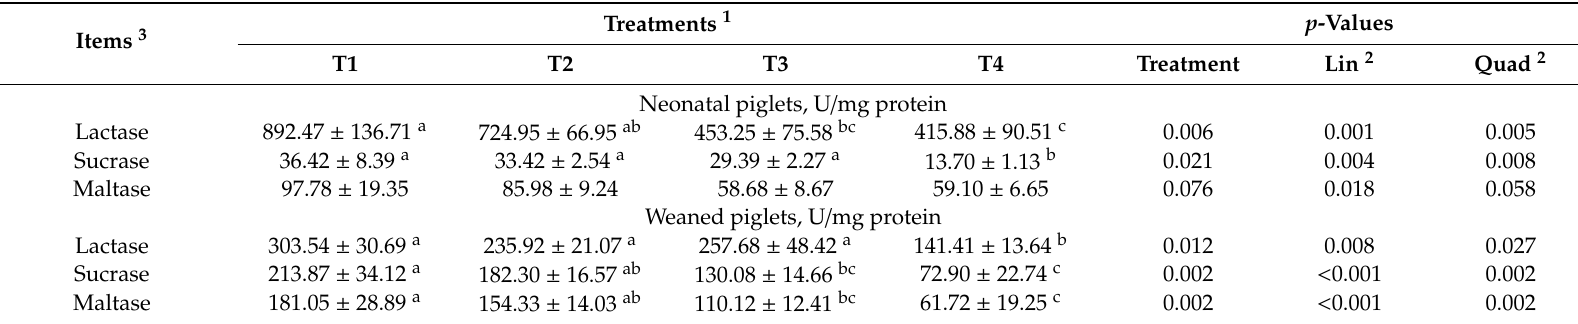
Table 10. E ff ects of the ratio of insoluble to soluble fiber in sow gestation diets on enzymatic activity in the jejunum in neonatal and weaned piglets. Items